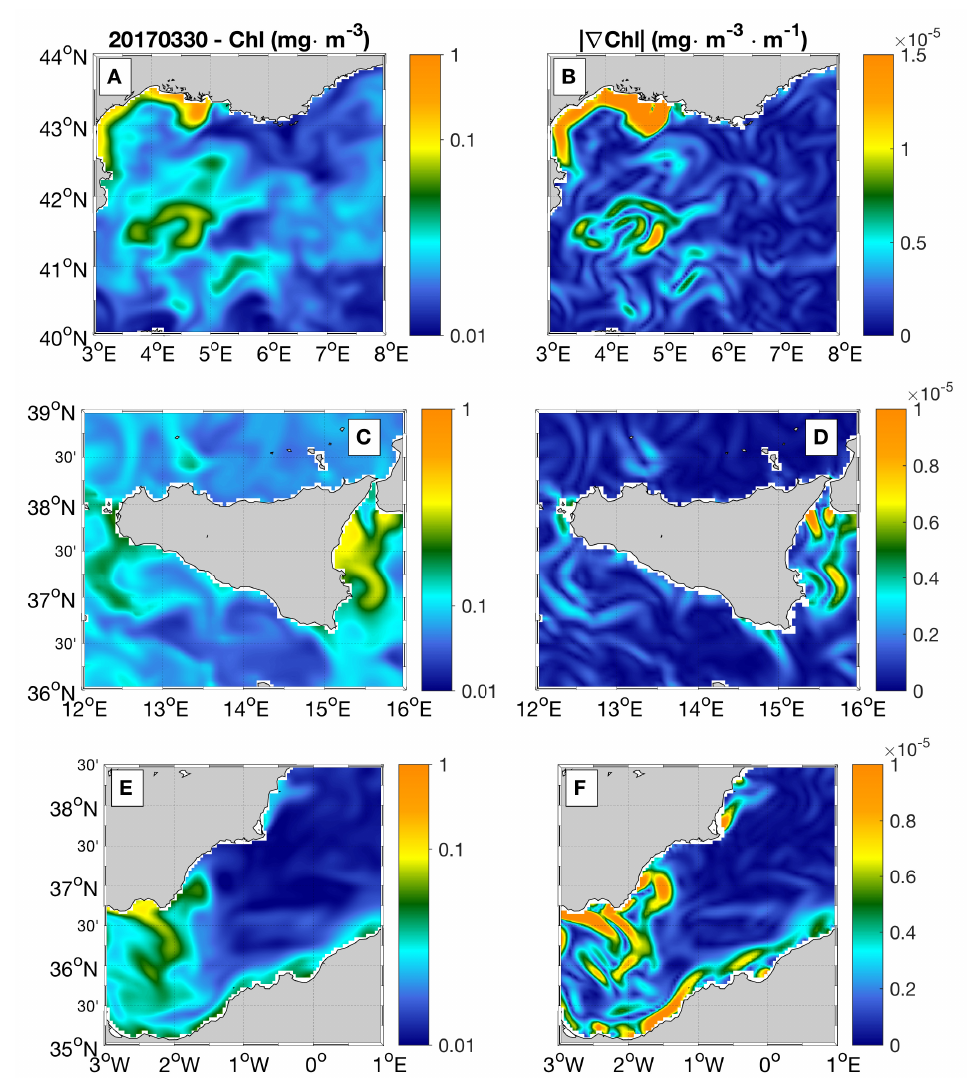
Figure 4. Surface Chl from the CMEMS MedBFM BIO model in: ( A ) the Northwestern Mediterranean, ( C ) the Sicily Channel, ( E ) the Western Mediterranean. ( B , D , F ) Chl spatial gradients magnitude | ∇ Chl|, same areas as ( A , C , E ),